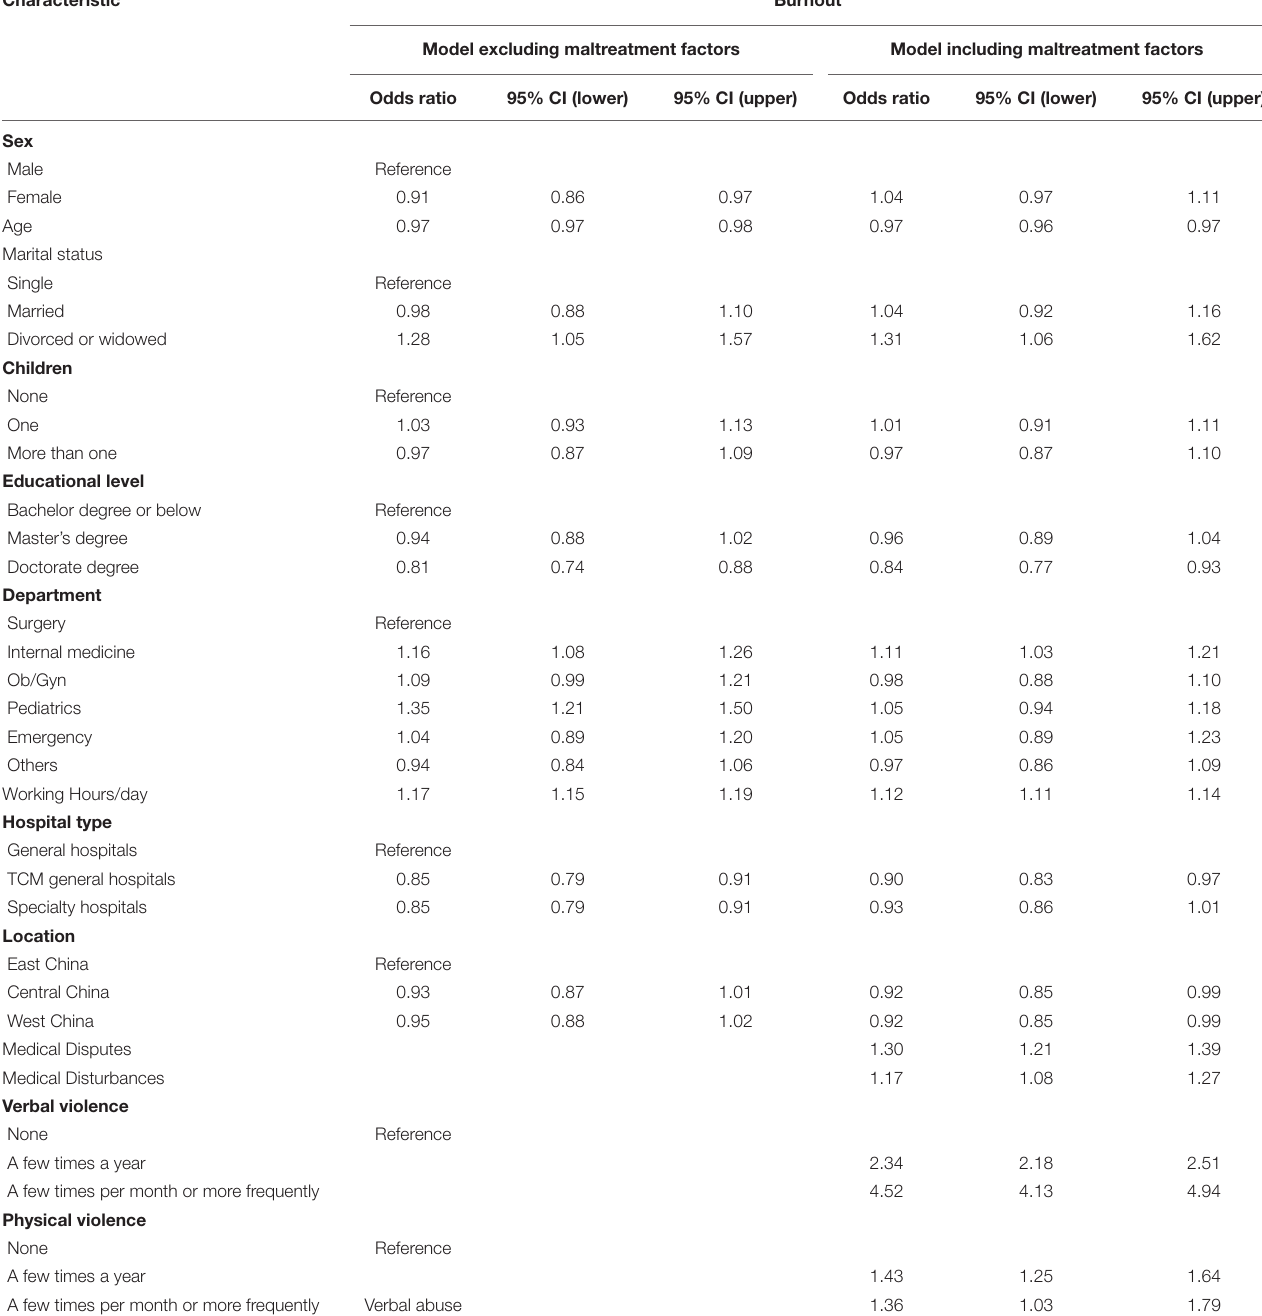
TABLE 3 | Factors associated with burnout among Chinese